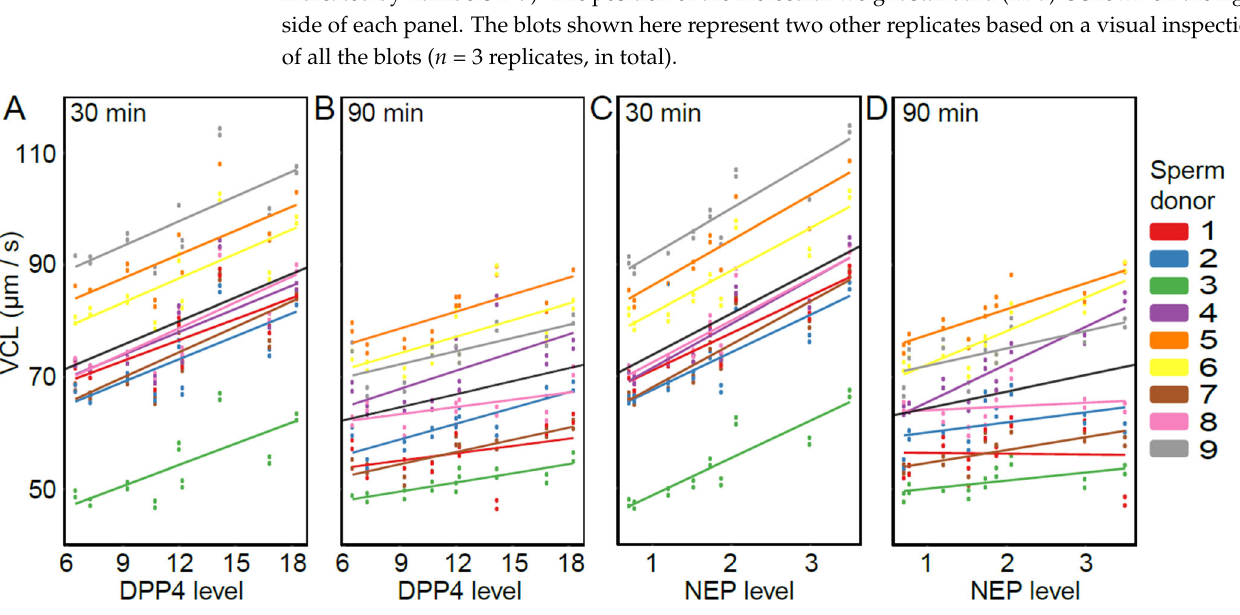
Figure 4. The association between sperm swimming velocity (VCL) and the abundance of DPP4 and NEP in SP samples: DPP4 30 min ( A ), DPP4 90 min ( B ), NEP 30 min ( C ), and NEP 90 min ( D ). Data points represent fitted values obtained from the LMM. Sperm donors are indicated by different colors and the black line represents the average slope across all males. Levels of DPP4 and NEP (x-axis) are shown as arbitrary unit